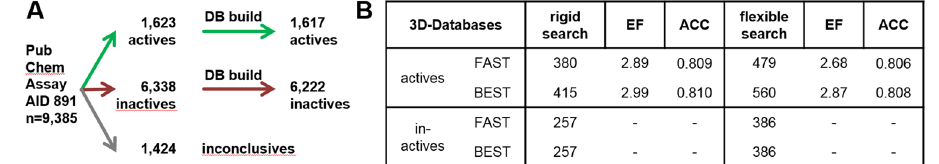
Figure 4. Validation of the workflow for building and profiling a 3D-database with the CYP2D6 inhibitor pharmacophore model. ( A ) The PubChem Assay AID891 was used as a test-database including 1623 active and 6338 inactive compounds. After the 3D conformer generation, 1617 actives and 6222 inactives remained in the database. ( B ) To generate the 3D-database we used the FAST and the BEST modes, respectively. For the profiling of the four 3D-databases, we applied a rigid and a flexible search with the already published pharmacophore model, respectively. The various settings yielded different hit lists, which compositions were quantified using the EF and